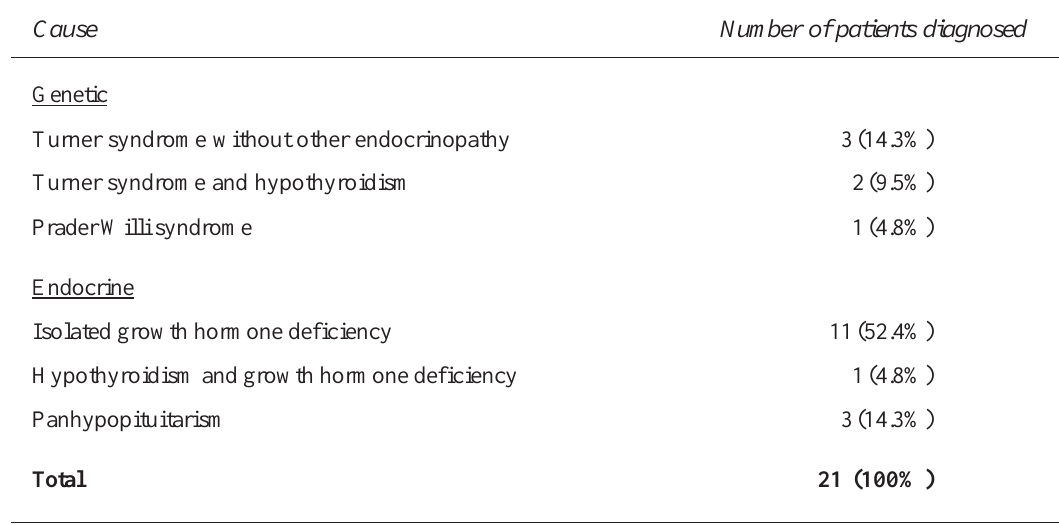
Table 2. Aetiology of short stature of adolescents who were initiated on growth hormone therapy Cause Number of patients diagnosed Genetic Turner syndrome without other endocrinopathy Turner syndrome and hypothyroidism Prader Willi